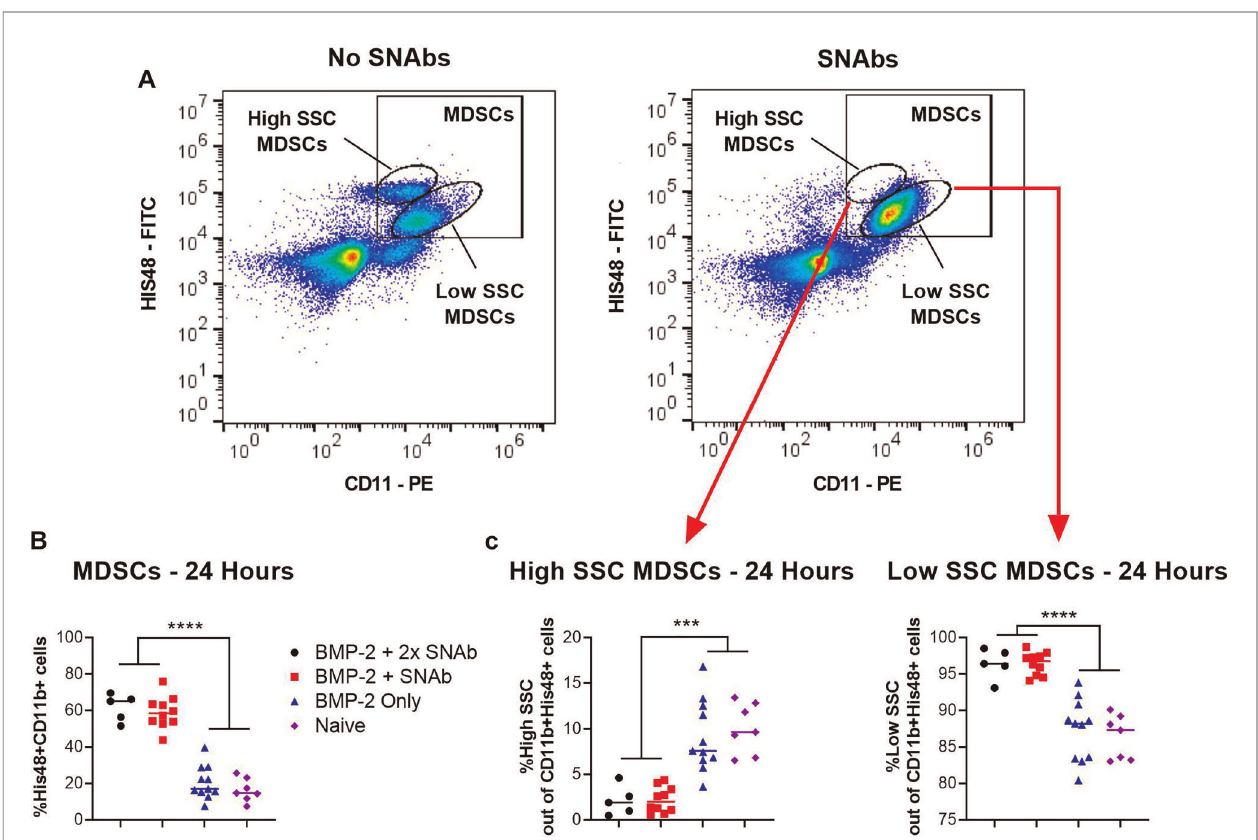
FIGURE 4 | MDSCs at 24 h post-SNAb treatment in the composite trauma model. ( A ) Flow cytometry dot plots showing two MDSC sub-populations. Systemic levels of total MDSCs ( B ) and the two MDSC subsets ( C ) at 24 h post-SNAb treatment in the composite trauma model. Signi fi cance was determined using a one-way ANOVA. *** P <0.001; **** P <0.0001 as indicated; n =5 to 11 per